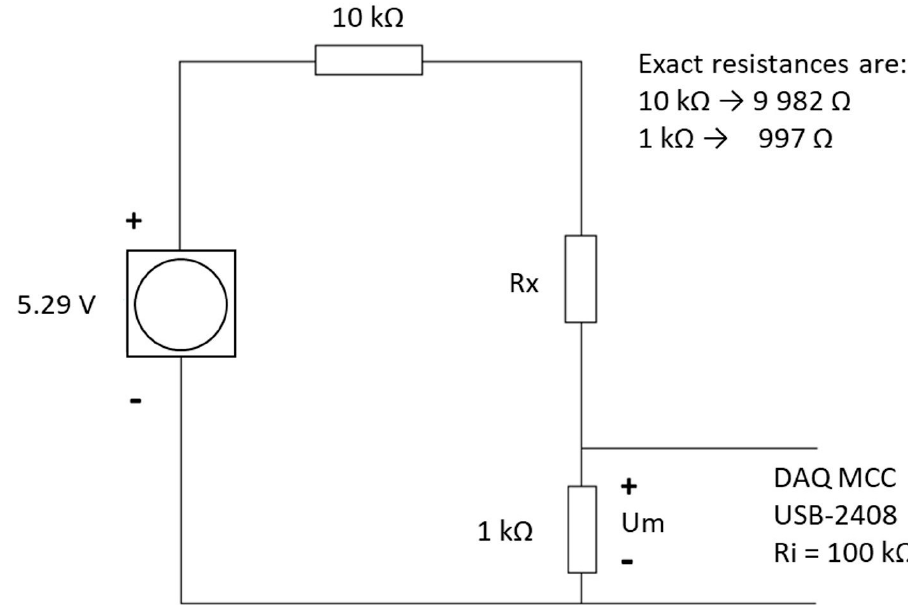
Figure 13. The measuring circuit diagram for the ‘in-socket’ measurements.